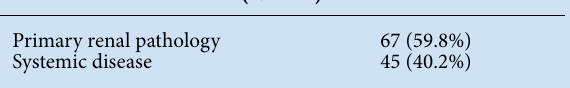
Table V. Diagnosis after percutaneous renal